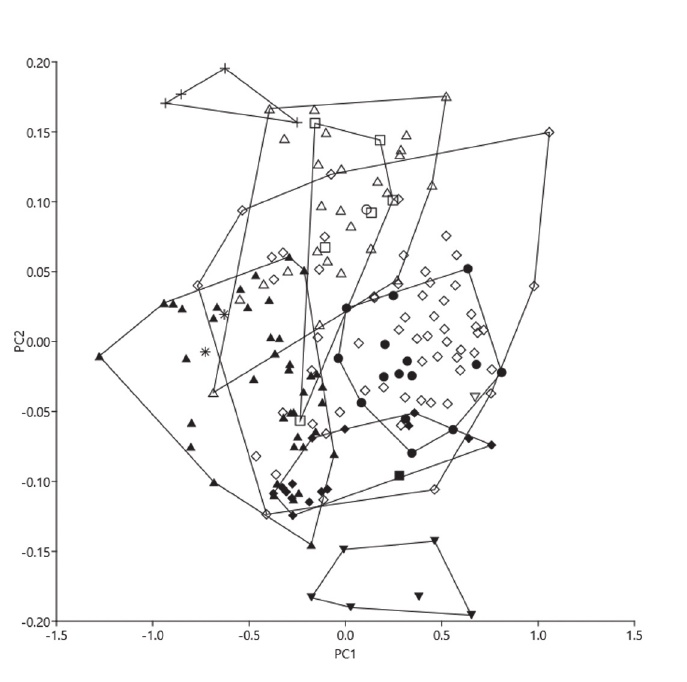
Fig. 3. Scatterplot of PC2 against PC1 for a PCA on 17 log-transformed measurements (n = 177) of Enteromius Cope, 1867: E. cf. miolepis (Boulenger, 1902) (◊), E. cf. brazzai (Pellegrin, 1901) ( ♦ ), E. cf. pellegrini (Poll, 1939) ( ∆ ), and E. cf. atromaculatus (Nichols & Griscom, 1917) ( ▲ ). Also shown are the type specimens examined of: E. miolepis (Boulenger, 1902) ( ○ ), E. holotaenia (Boulenger, 1904) (●), E. eutaenia (Boulenger, 1904) (□), E. kerstenii (Peters, 1868) ( ■ ), E. brazzai (Pellegrin, 1901) ( ), E. tshopoensis (De Vos, 1991) (▼), E. pellegrini (Poll, 1939) (+), and E. atromaculatus (Nichols & Griscom, 1917) (